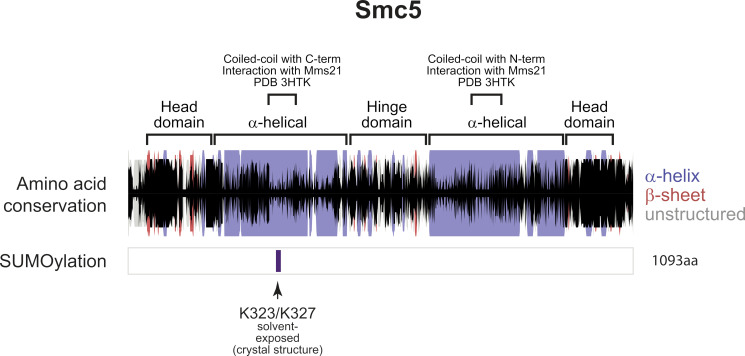
Secondary structure and helical projections of Smc5.Cartoons showing secondary structure predictions (α-helix: purple bar, β-sheet: red bar, unstructured: gray bar) and amino acid conservation (black bar). Height of the black bars represents the level of amino-acid conservation. SUMO sites are shown below together with information regarding location in structure and solvent exposure.